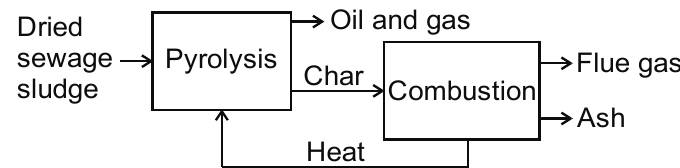
Figure 17. Two-stage “Pyrobustor” reactor for thermal treatment of sewage sludge.